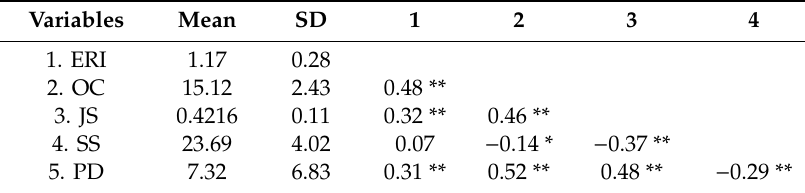
Table 2. Descriptive statistics and correlations between the study